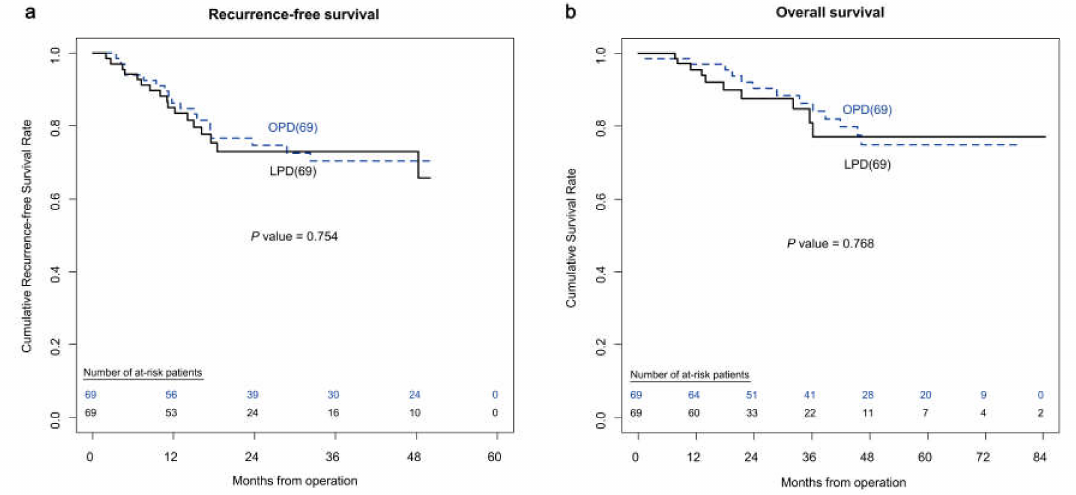
Figure 2. ( a ) Kaplan–Meier curves of recurrence free survival after surgery in propensity-score-matched patients who underwent OPD or LPD. ( b ) Kaplan–Meier curves of overall survival after surgery in propensity-score-matched patients who underwent OPD or